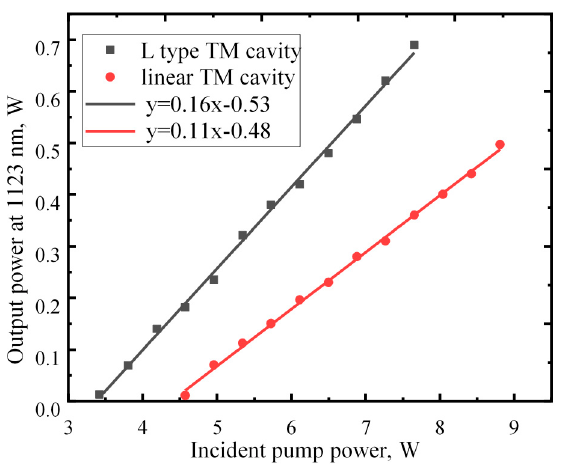
Figure 2. The average output power of the 1123 nm laser versus the incident pump power.